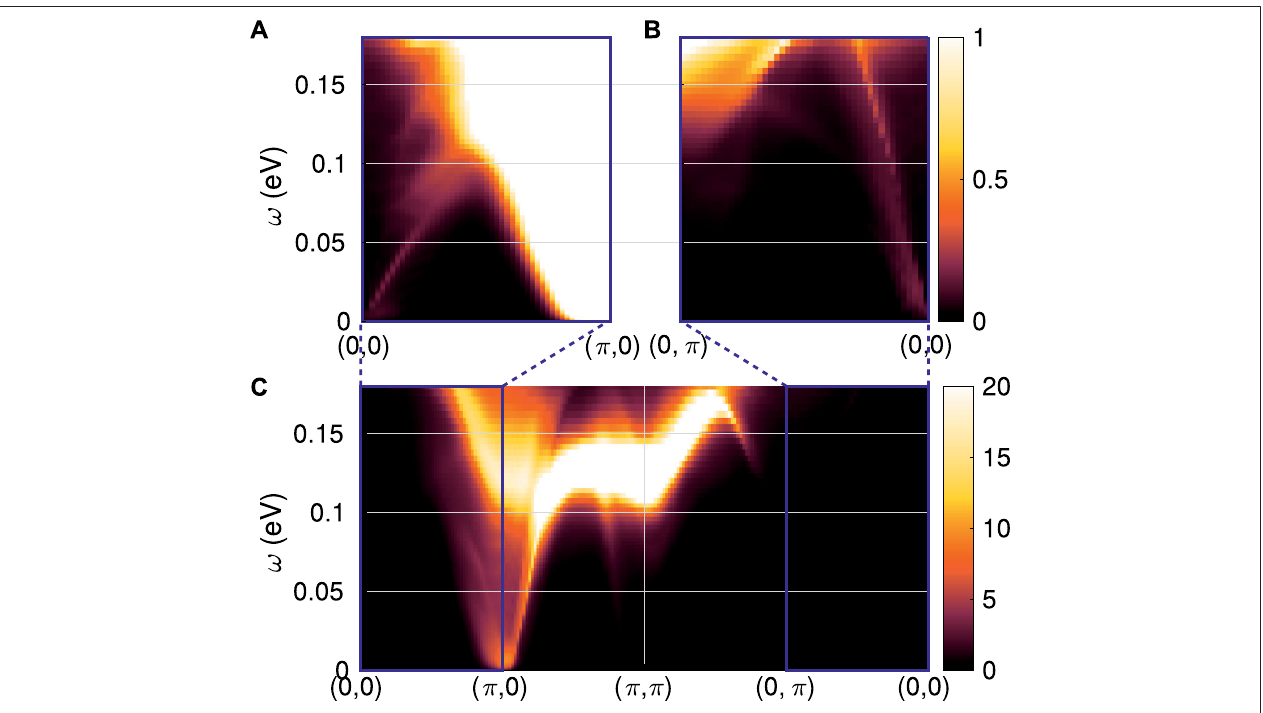
FIGURE 2 | Spin susceptibility: − Im χ ( q , ω ). (A,B) Zoom-in to the details of the spin susceptibility as calculated using the modi fi ed RPA approach for U = 0.57 eV and J = U /6, compare Figure 9C of Ref. [33]. Close to q = (0, 0) paramagnon modes are dispersing linearly up as seen towards the X point (A) , and towards the Y point (B) . The overall intensity close to q = ( π , 0) is much larger and exhibits a dispersion with broad maximum around ω ≥ 0.1 eV (C) compared to the relatively sharp paramagnon dispersion close to q = (0,